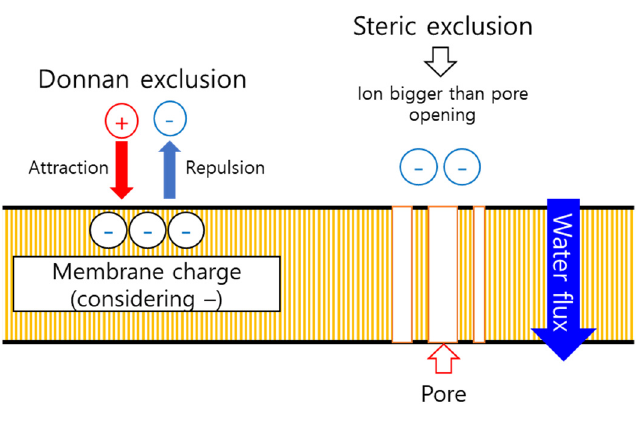
Figure 10. Synergetic effect diagram of ionomer coating on the removal